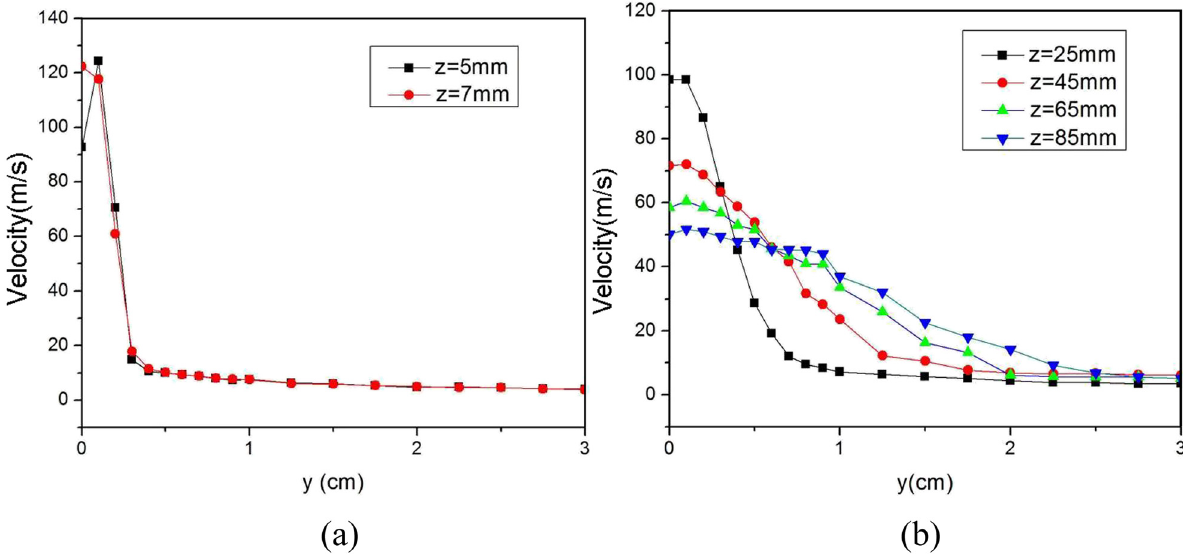
Figure 5: Velocity distribution on di ff erent z - lines: ( a ) the area near the die; ( b ) the middle area and the area away from the